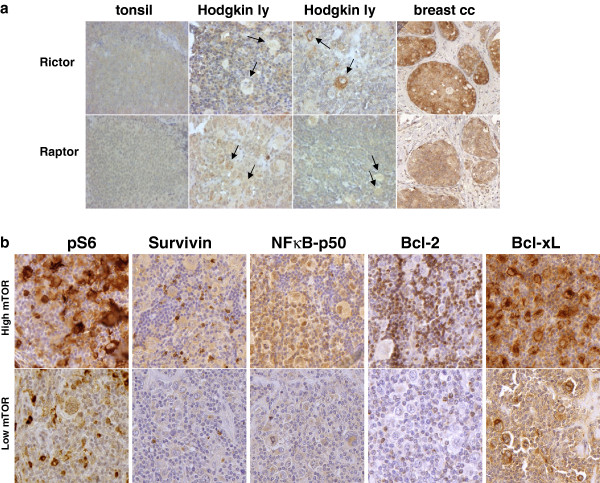
Analysis of mTOR related protein expression in HL. a. Hodgkin-lymphomas with no Rictor overexpression. Rictor and Raptor expression in HRS cells is similar to reactive lymphocytes (0/1+). Rictor expression is 0/1+ in the majority of HL cases (a representative example is shown); Rictor expression was high only in one HL sample (also shown here; arrows indicate tumor cells). Breast cancer cells show Rictor overexpression (2+/3+). (IHC, 200X, 400X). b. NF-kappaB-p50 and Bcl-xL expression may corralete to mTOR activity in HLs based on several IHC stainings; however, this tendency did not reach statistical significance (see results). (Representative IHC stainings are shown in cases with high and low mTOR activity; 400X).